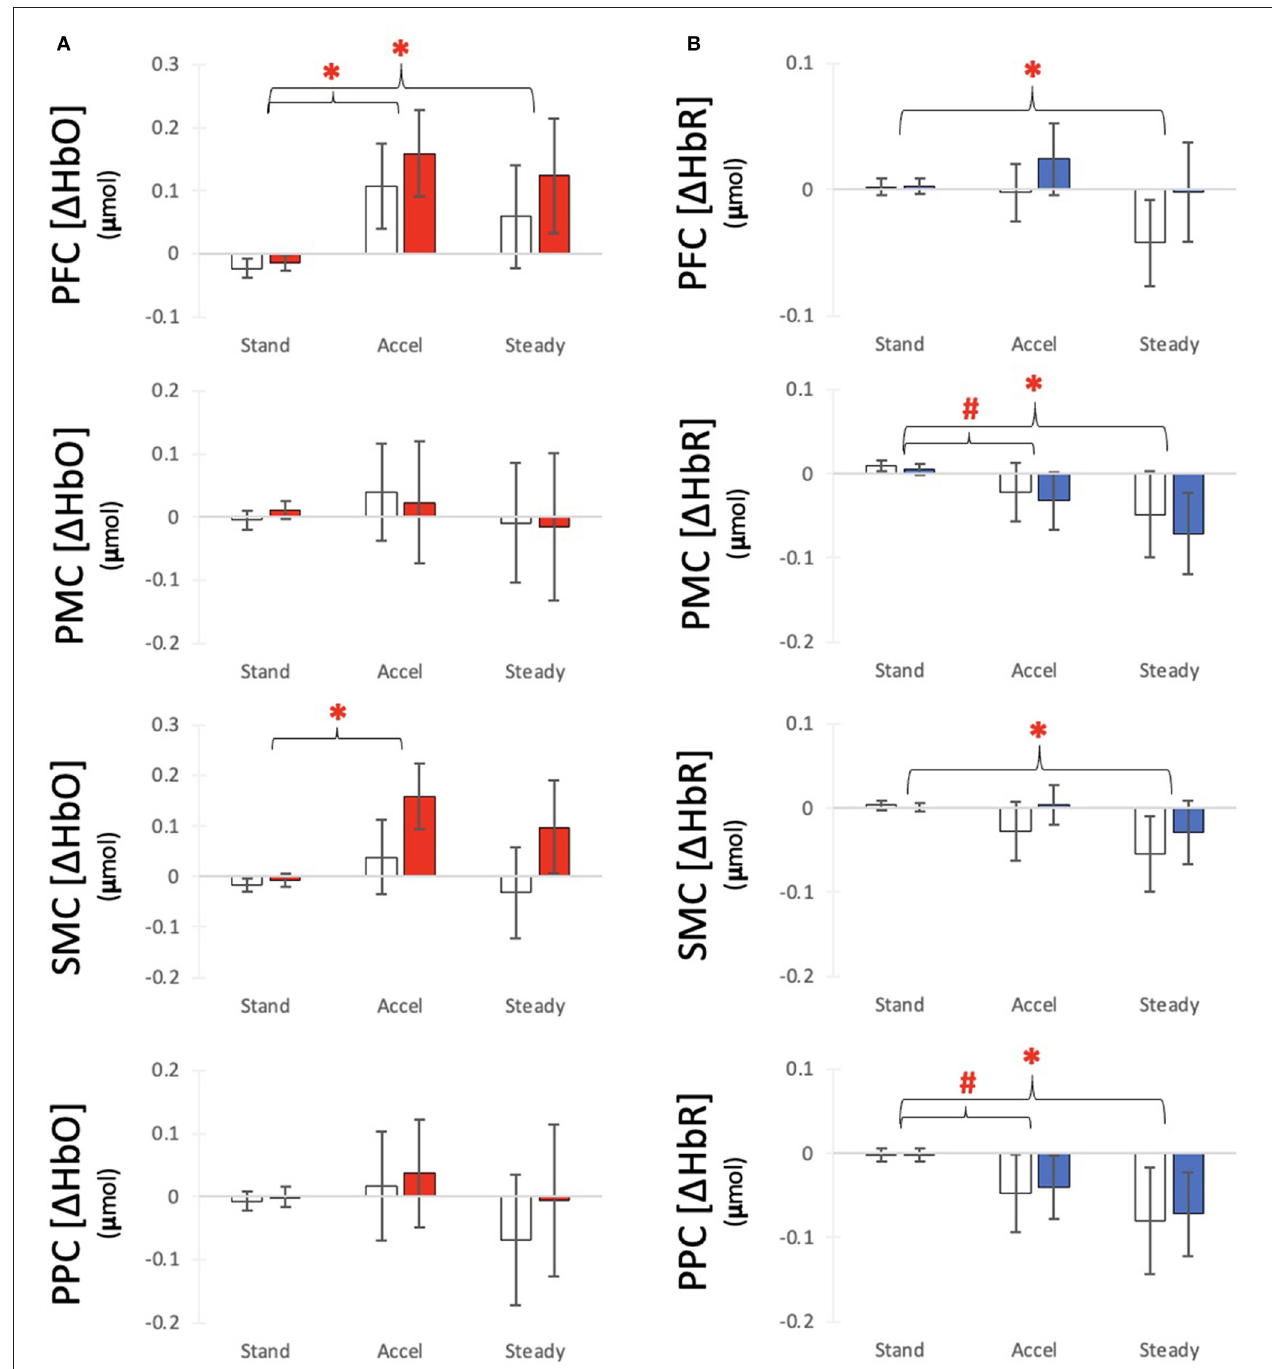
FIGURE 3 | Average (A) HbO and (B) HbR response for each time segment with for each region of interest. Bars indicate average responses for the contralesional side (white) and ipsilesional side (colored) and error lines indicate standard error. # Indicates a differences from Baseline with alpha at 0.05 *Indicates a significant difference from Baseline after correction for multiple